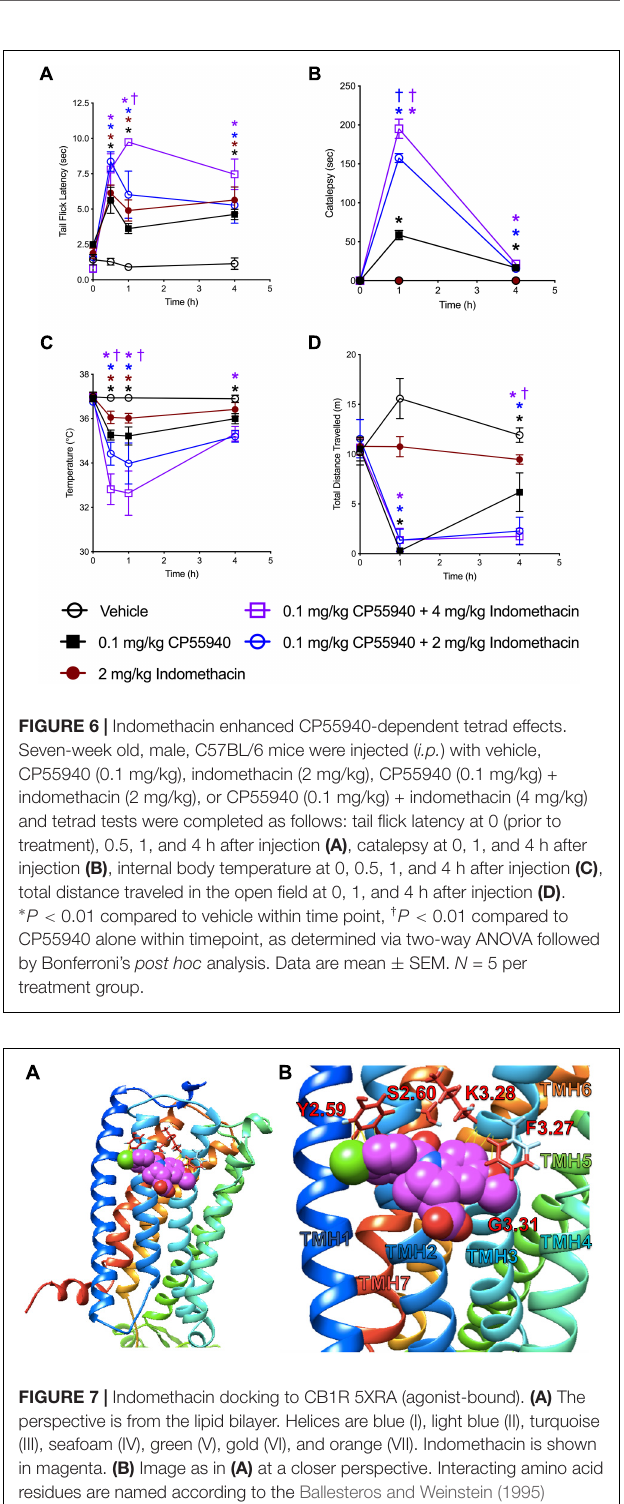
is known to interact with a number of proteins, including the multidrug resistance proteins 1 and 4, COX-1, COX-2, PTGDR2/CTRH2, PPAR γ , and the AEA-metabolizing